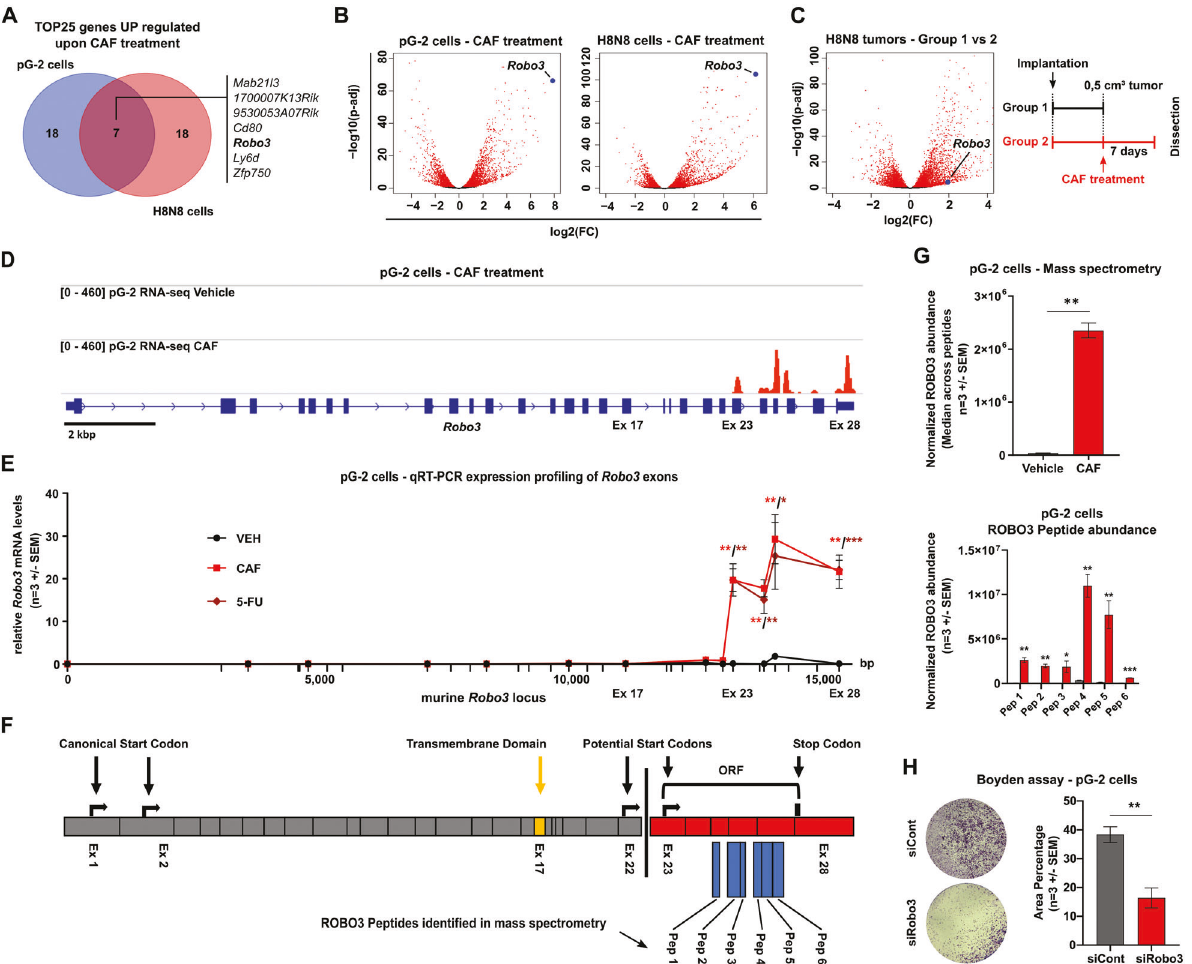
Fig. 1 Murine BLBC cells strongly upregulate an uncharacterized short isoform of Robo3 during conventional chemotherapy survival. A Venn diagram of the top 25 most strongly upregulated genes in pG-2 and H8N8 cell lines after 48 h CAF chemotherapy (log2FC > 1 and padj < 0.05 relative to vehicle treatment). B Log2 fold change (Log2FC) gene expression volcano plots for pG-2 and H8N8 cell lines treated with 1:32 CAF chemotherapy for 48 h relative to vehicle treatment. Strongly upregulated Robo3 labeled (blue). Genes exhibiting a signi fi cant regulation with an adjusted p-value (padj) of < 0.05 are highlighted (red). C Treatment scheme for groups 1 and 2 of WAP-T mice injected with H8N8 for tumor induction and subsequent CAF chemotherapy treatment (right panel). Log2FC gene expression volcano plots comparing groups 1 and 2 (left panel). Upregulated Robo3 labeled (blue). Genes exhibiting a signi fi cant regulation with an adjusted padj of < 0.05 are highlighted (red). D Integrated Genome Browser (IGV) tracks of mRNA-seq of pG-2 cells treated with CAF or vehicle for 48 h. Reads corresponding to Robo3 transcription (red) range from exon 23 to exon 28 upon CAF treatment but are absent in vehicle controls. E Overview of qRT-PCRs with primers covering the entire Robo3 gene supports the restriction of Robo3 transcription to exons 23 – 28 in pG-2 cells after CAF or 5-FU treatment for 48 h relative to vehicle. F Schematic depiction of potentially translated (red) and non-translated (grey) Robo3 exons. Analysis of open reading frames (ORF) shows a possible start codon for translation with exon 23. ROBO3 peptide sequences identi fi ed by mass spectrometry are mapped against the amino acid sequence (blue). Canonical and newly predicted ORFs of ROBO3 terminate on an identical stop codon. The coding sequence for the ROBO3 transmembrane region is absent from the novel isoform (yellow). G Protein abundance of murine ROBO3 after CAF treatment in comparison to a control. The area under the curve of extracted fragment ion chromatograms was summed up and averaged for six peptides unique for ROBO3s. H Representative crystal violet stainings of a migration assay (Boyden chamber) on pG-2 cells treated either with siRobo3 or siRNA control (left panel). Quanti fi cation of migratory cells (area fraction) for each condition (right panel). E, G , H: Error bars represent mean ± SEM of three biological replicates, unpaired t-test: * p < 0.05; ** p < 0.01; *** p <